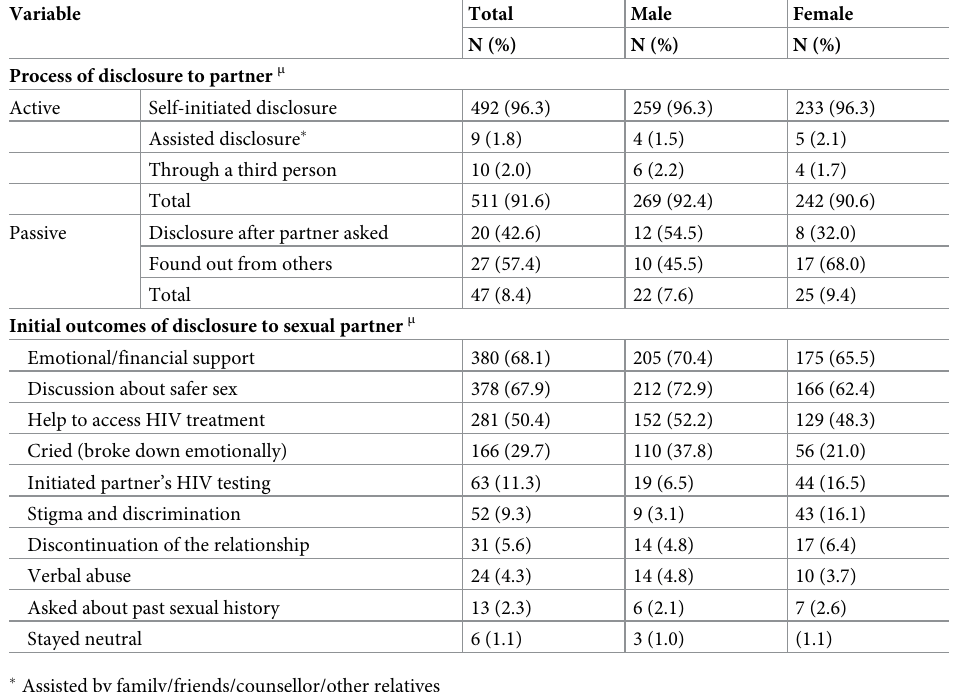
Table 5. Processes and initial outcomes of disclosure to most recent sexual partner by